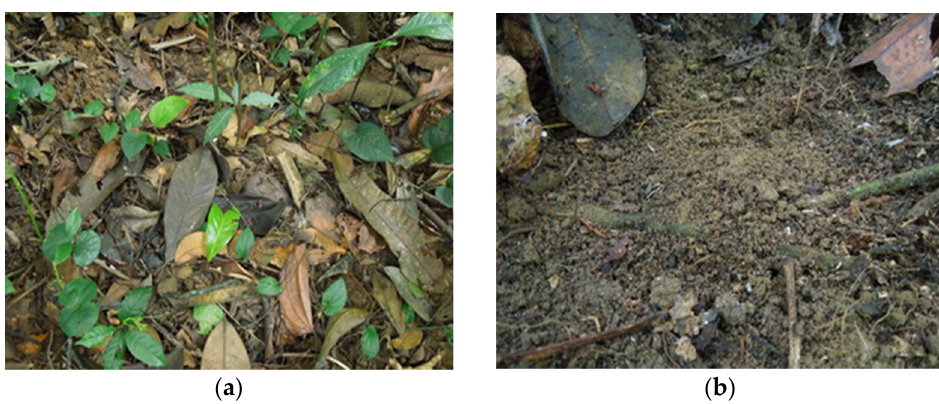
Figure 1. Leaf litter ( a ) and dark brown ferrallitic soil ( b ) sampled from Site 1 of the Xuan Son Na ‐ tional Park. National